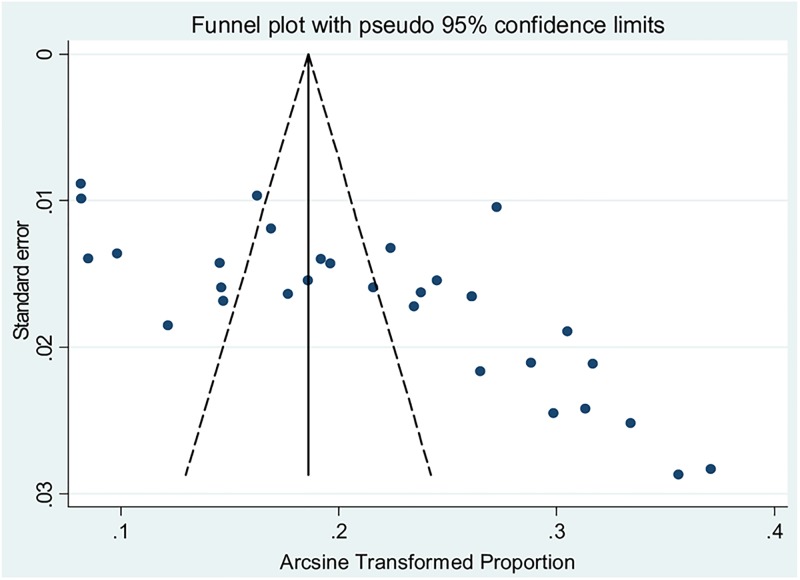
Funnel plot with 95% confidence limits of the pooled prevalence of diarrhea among under-five children in Ethiopia.